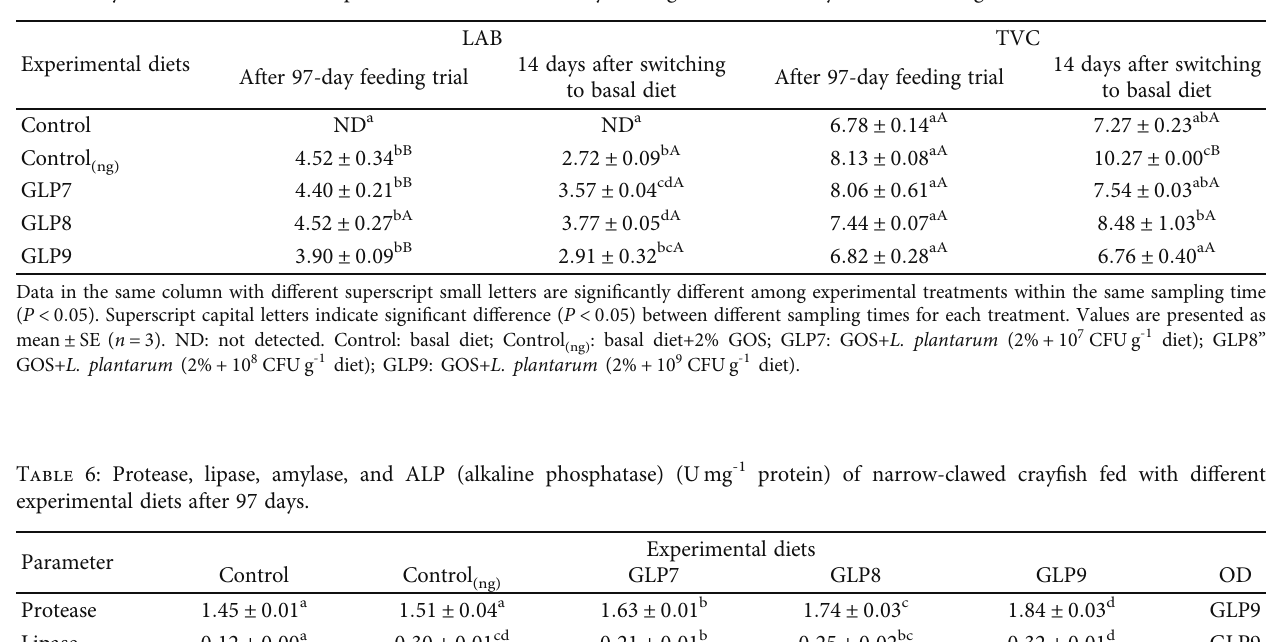
Data in the same column with di ff erent superscript small letters are signi fi cantly di ff erent among experimental treatments within the same sampling time ( P < 0 : 05 ). Superscript capital letters indicate signi fi cant di ff erence ( P < 0 : 05 ) between di ff erent sampling times for each treatment. Values are presented as mean ± SE ( n = 3 ). ND: not detected. Control: basal diet; Control (ng) : basal diet+2% GOS; GLP7: GOS+ L. plantarum ( 2 % + 10 7 CFUg -1 diet); GLP8: GOS